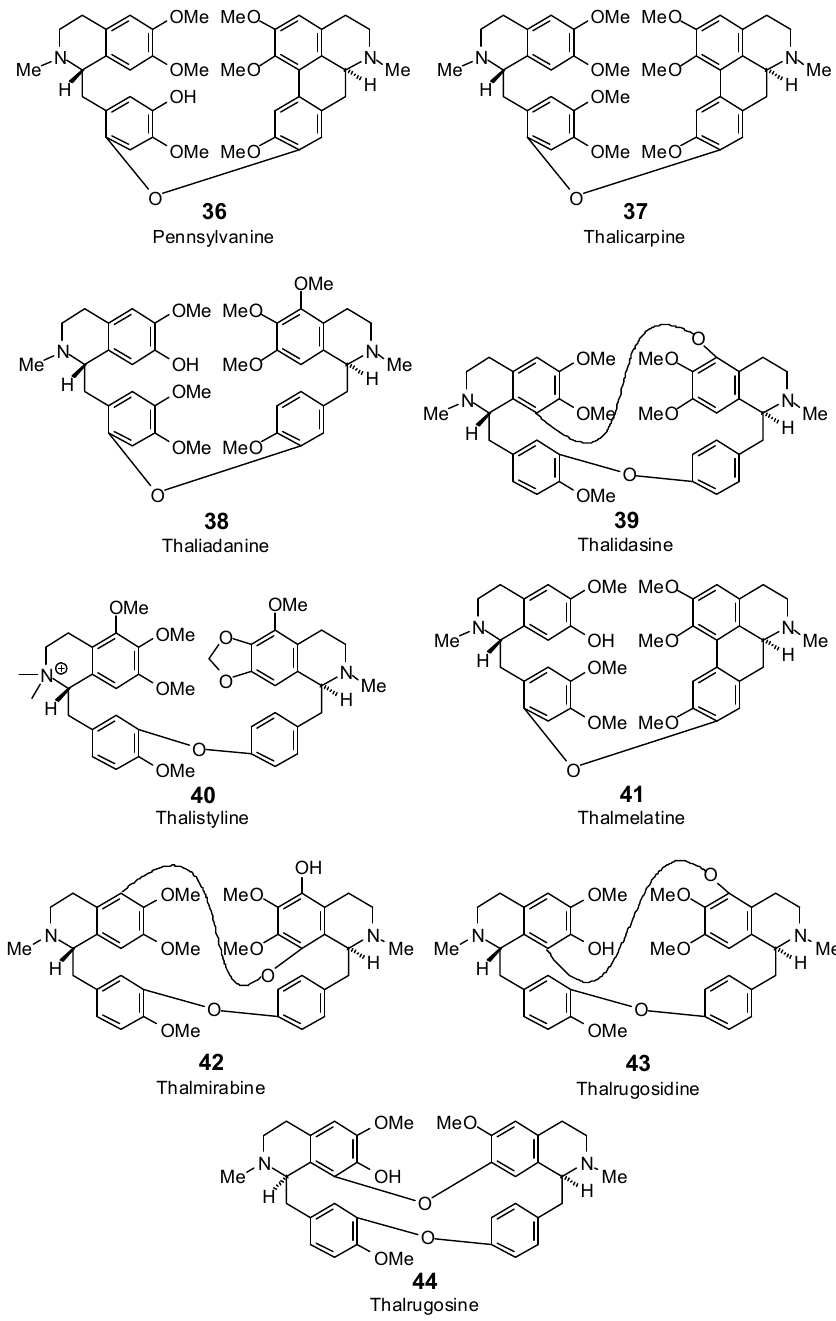
Figure 2. Isoquinoline alkaloids examined in this work.